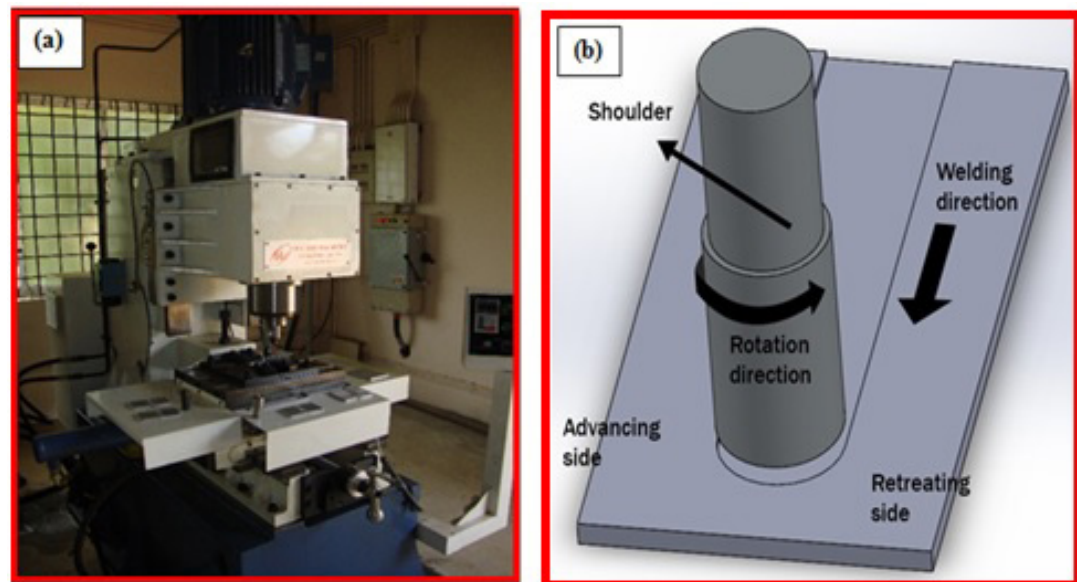
Figure 1. (a) A photographic view of FSW arrangement. (b) Schematic of FSW